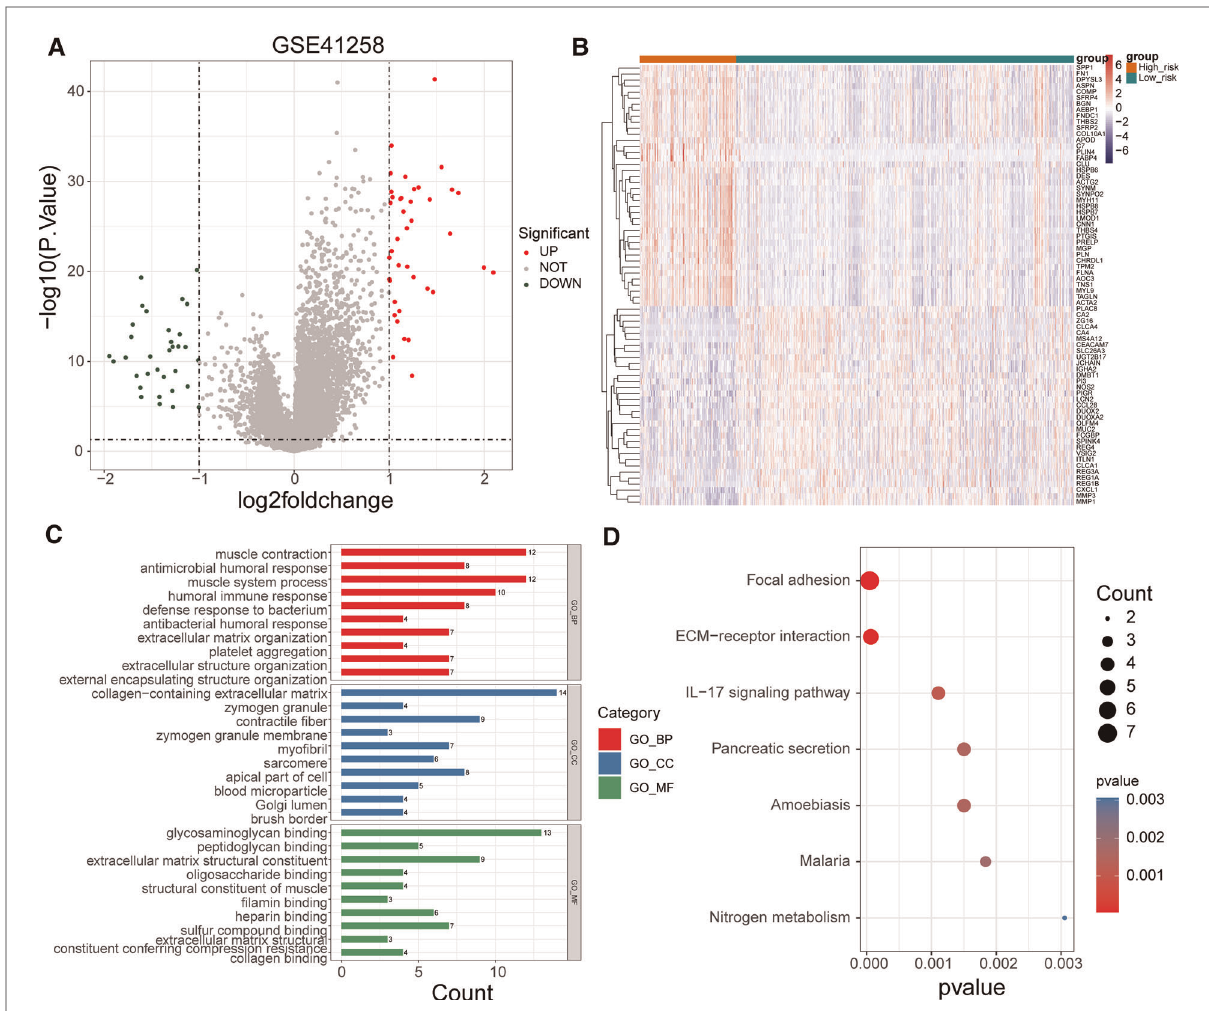
FIGURE 6 Functional enrichment of DEGs between high- and low-risk groups. ( A ) Volcano map of DEGs between high- and low-risk groups. ( B ) Heat map of DEGs between high- and low-risk groups ( C ) Top 10 GO terms enriched by DEGs between high- and low-risk groups under BP, CC, and MF subcategories. ( D ) KEGG pathways enriched by DEGs between high- and low-risk